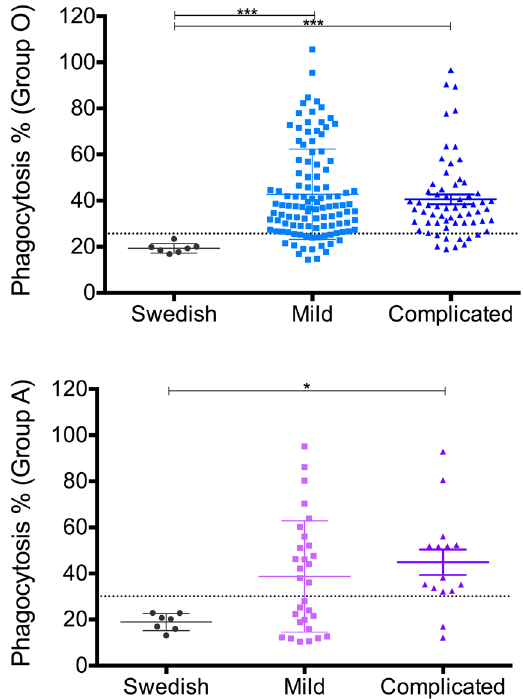
Figure 3. Opsonization for phagocytosis. Percentage of phagocytosis after opsonization of pRBCs -grown in group O (top panel) and group A RBCs (low panel)- with pediatric sera stratified by malaria clinical presentation (mild and complicated) and compared with Swedish adults controls. Scatter dot plots show the means and SD. Differences between the groups were determined using a Kruskal-Wallis test. The dotted lines on each graph represent the threshold above which samples were considered as positive